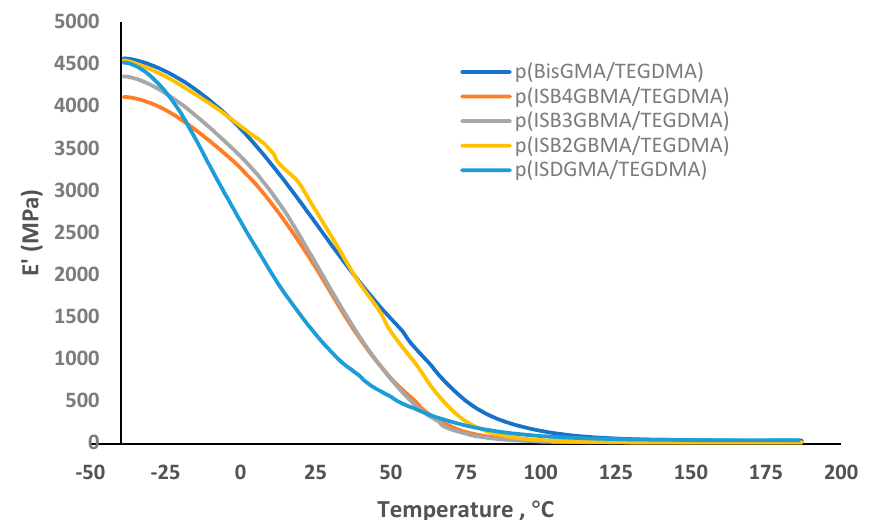
Figure 10. Storage modulus of p(BisGMA/TEGDMA), p(ISB4GBMA/TEGDMA), p(ISB3GBMA/TEGDMA), p(ISB2GBMA/TEGDMA), and p(ISDGMA/TEGDMA) at 60:40 wt%. The lower water sorption of p(ISB2GBMA/TEGDMA) at 39 µg/mm 3 was statistically different from the water sorption of p(ISB4GBMA/TEGDMA) at 44 g/mm 3 . However, the polymer derived from BisGMA had the lowest water sorption at 26 µg/mm 3 , and the polymer derived from ISDGMA had the highest at 73 µg/mm 3 , as shown in Figure 11.